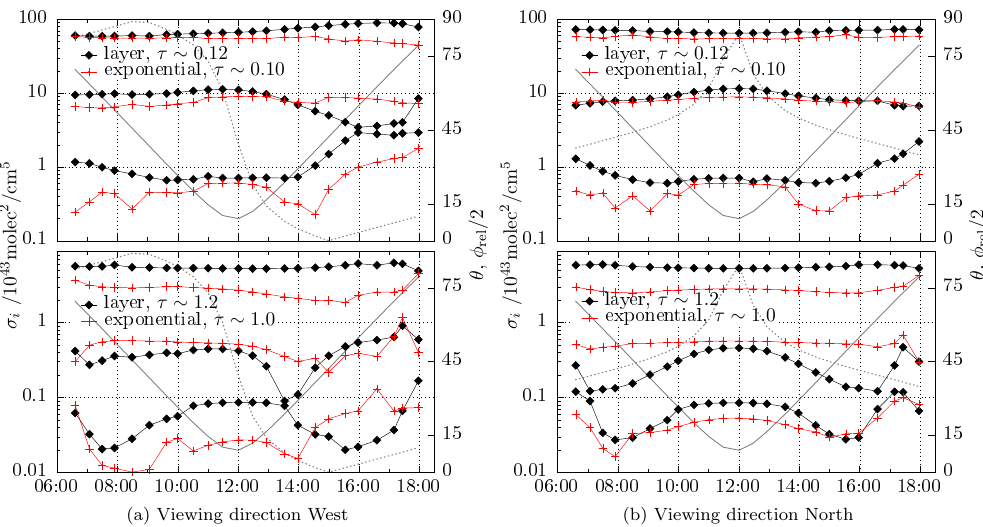
Fig. 3. The three non-zero singular values σ i of the Jacobian matrix for the forward model (without ˜ I ) using the profile parameters k L , τ L and τ E for the same ground layer profiles as in Fig. 2. For comparison, also shown are the first three non-zero singular values σ i for exponential profiles with scale height ζ =1km and ground extinction coefficients k L of 0.1 and 1km − 1 , respectively. (a) Viewing direction west, and (b) north.